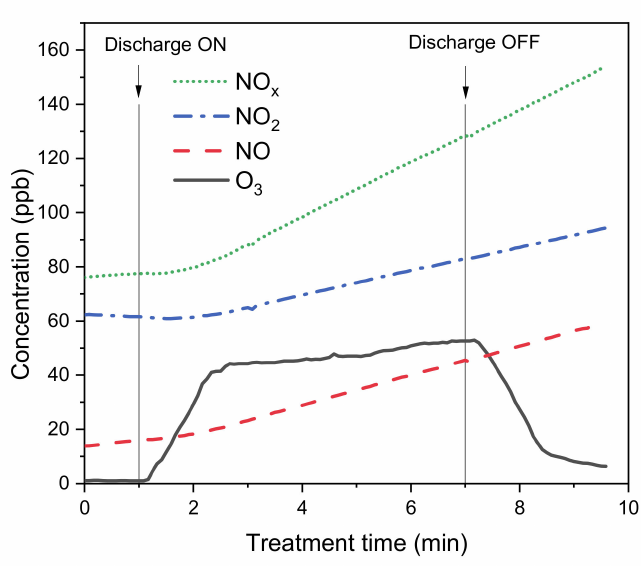
Figure 4. NO, NO 2 , NO x and O 3 concentration profiles measured before, during and after plasma treatment of 50 mL of ultrapure water in the PG reactor using superficial discharge.